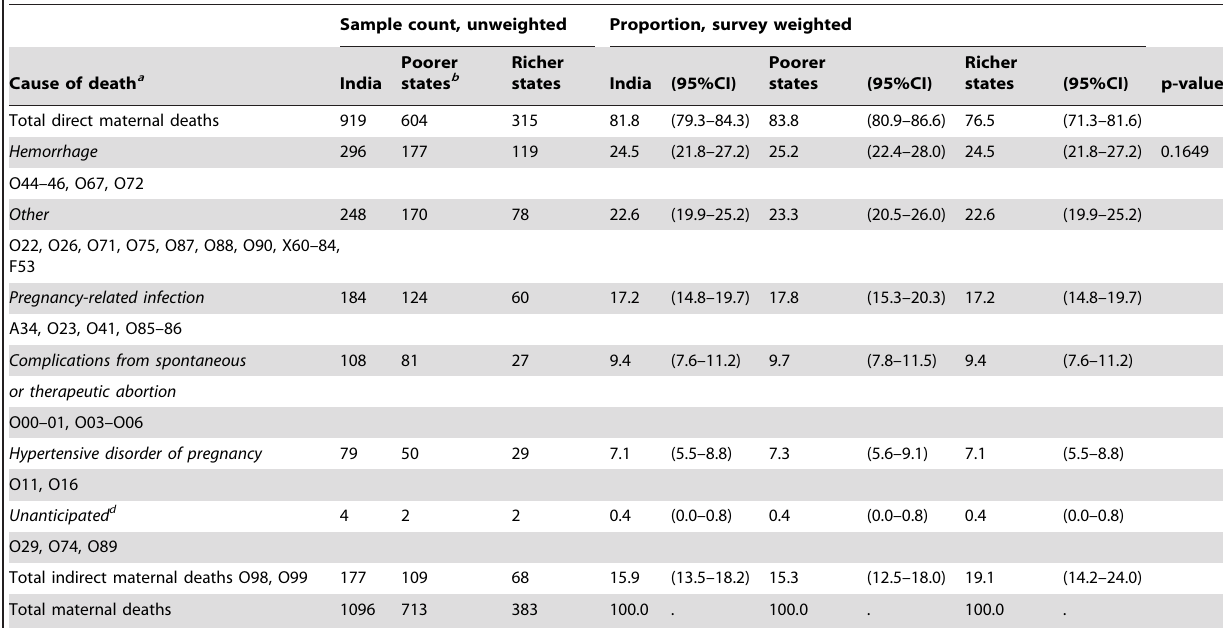
Table 2. Cause of death distribution of 1096 maternal